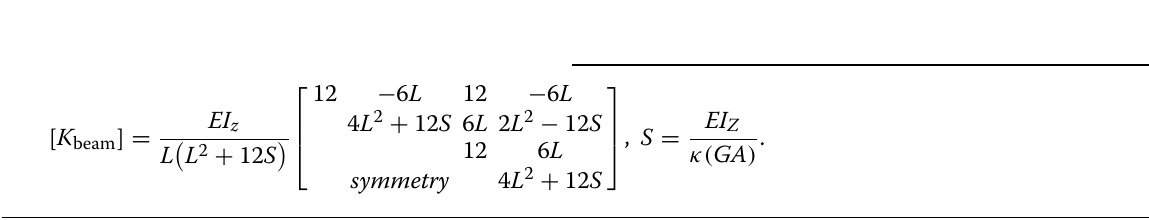
1.57) in three-point bending =